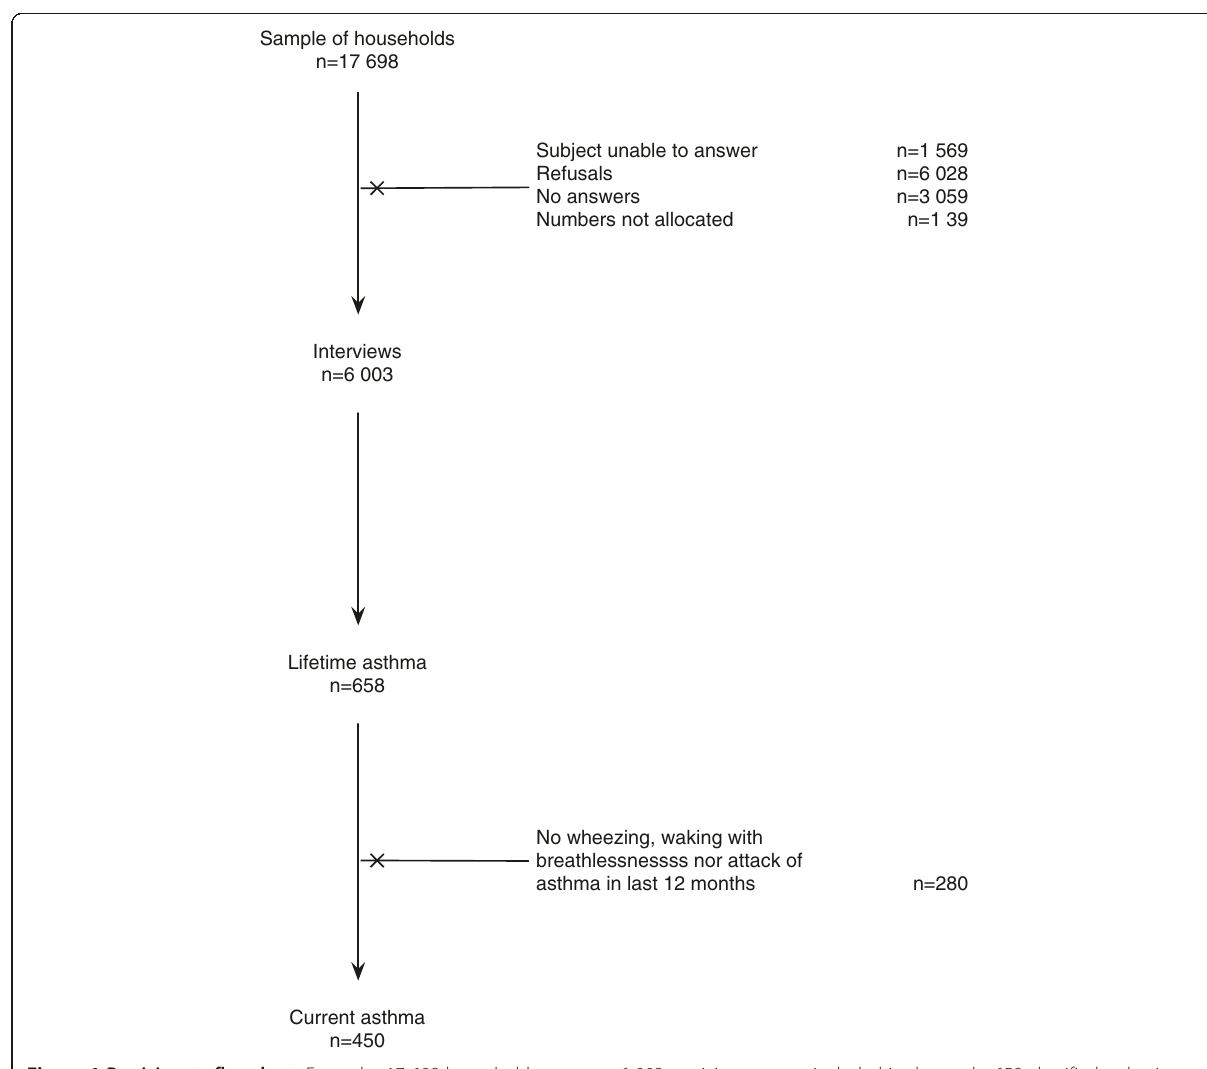
Figure 1 Participants flowchart. From the 17 698 households contacts, 6 003 participants were included in the study; 658 classified as having ‘ Lifetime asthma ’ and 450 as having ‘ Current asthma ’